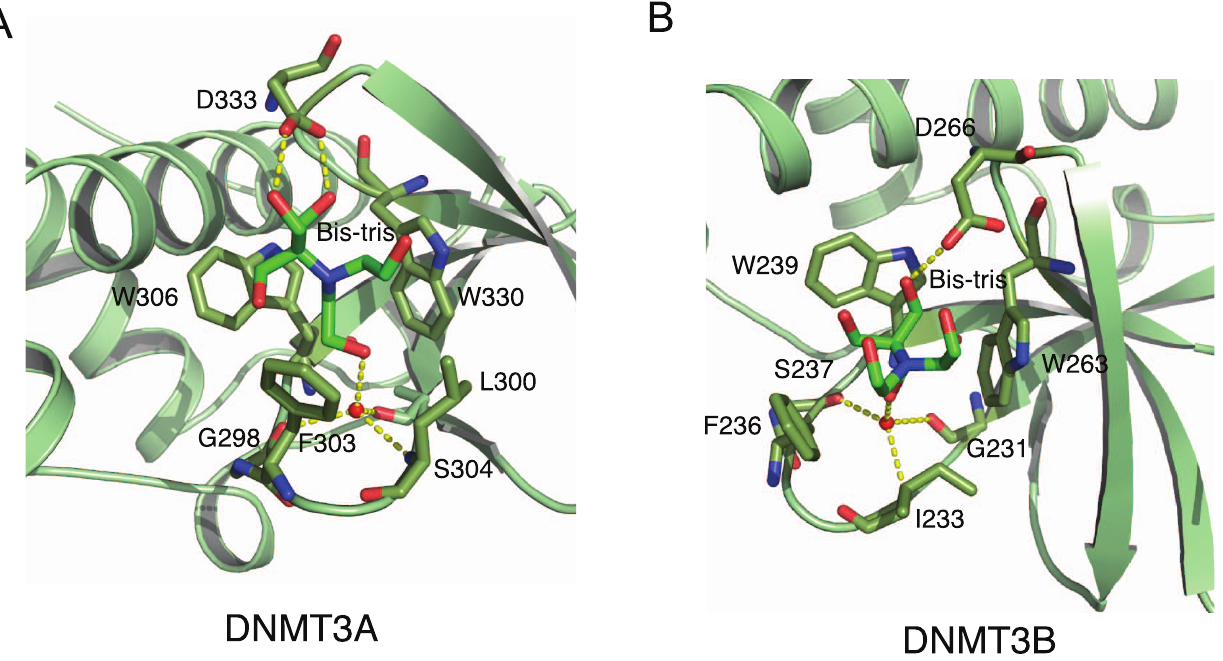
Figure 5. PWWP domains of DNMT3A and DNMT3B bind a bis-tris molecule in their respective aromatic cage. (A) The detailed interactions between DNMT3A and a bis-tris molecule. (B) The detailed interactions between DNMT3B and a bis-tris molecule. The bis-tris molecule is shown in a green stick model, and the interacting residues from the PWWP domain are also shown in stick models. Hydrogen bonds are shown in dashed lines.